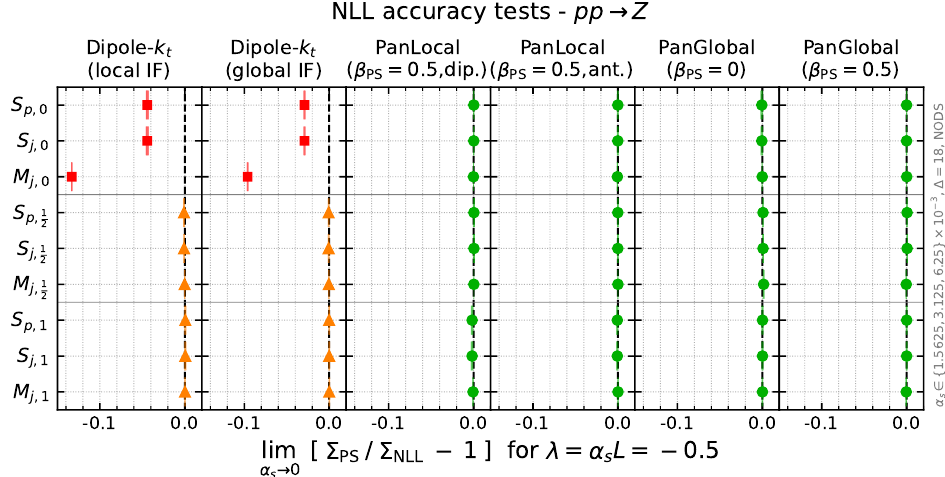
Figure 4. Summary of deviations from NLL for several global observables for the process q ¯ q → Z and λ = − 0 . 5 . Red squares denote a clear NLL failure; amber triangles indicate a NLL fixed- order failure that is masked at all orders; green circles are used when the shower passed both the numerical NLL tests and the fixed-order recoil tests. The α s → 0 result is obtained by quadratically extrapolating the shower results at α s = 0 . 00625 , 0 . 003125 and 0 . 0015625 , and includes a systematic error that is evaluated as the change in the α s → 0 extrapolation when one uses α s = 0 . 0125 instead of α s = 0 . 003125 . The showers include a dynamic cutoff ∆ = 18 , which functions as discussed in our earlier e + e − tests [8,